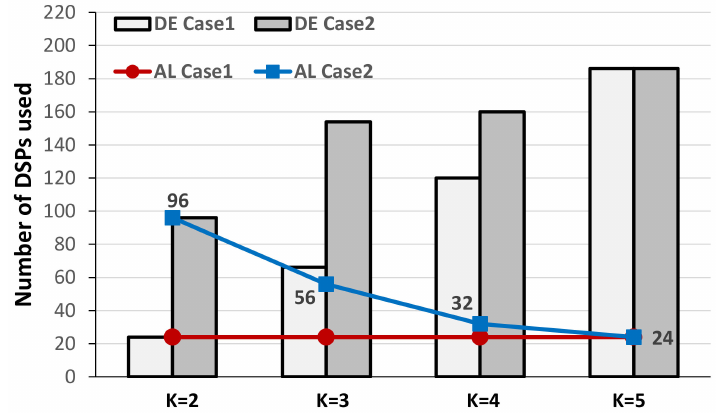
Figure 11. Design space exploration within the XC7Z020 device at the stride S =